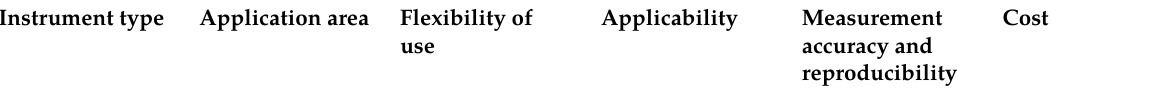
Table 1: Characteristics of the three main categories of NIRs devices. Instrument